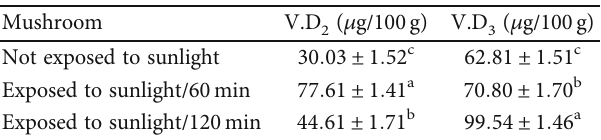
Table 2: E ff ect of exposure to sunlight on the formation of vitamins D and D in fresh 2 3